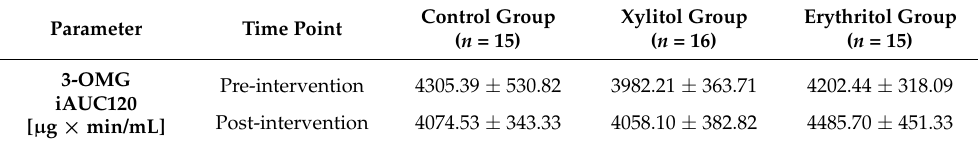
Table 3. 3-OMG iAUC120 (mean ± SEM) for each group before and after intervention.